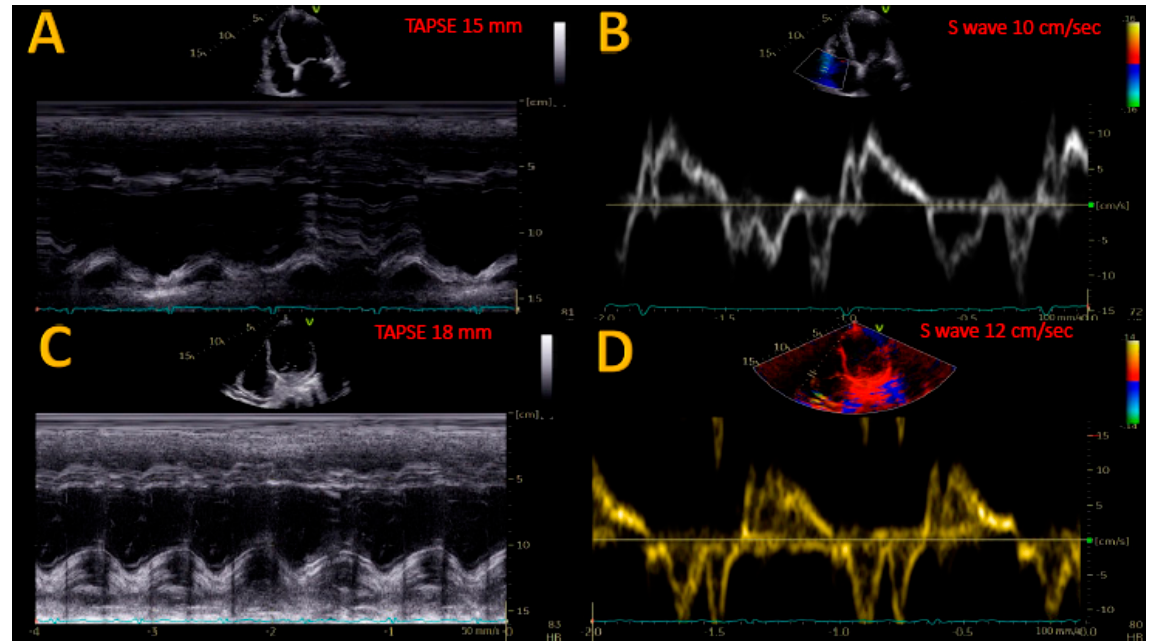
Figure 2. Effects of CCM therapy of right ventricular contractility indexes. * = p < 0.05.